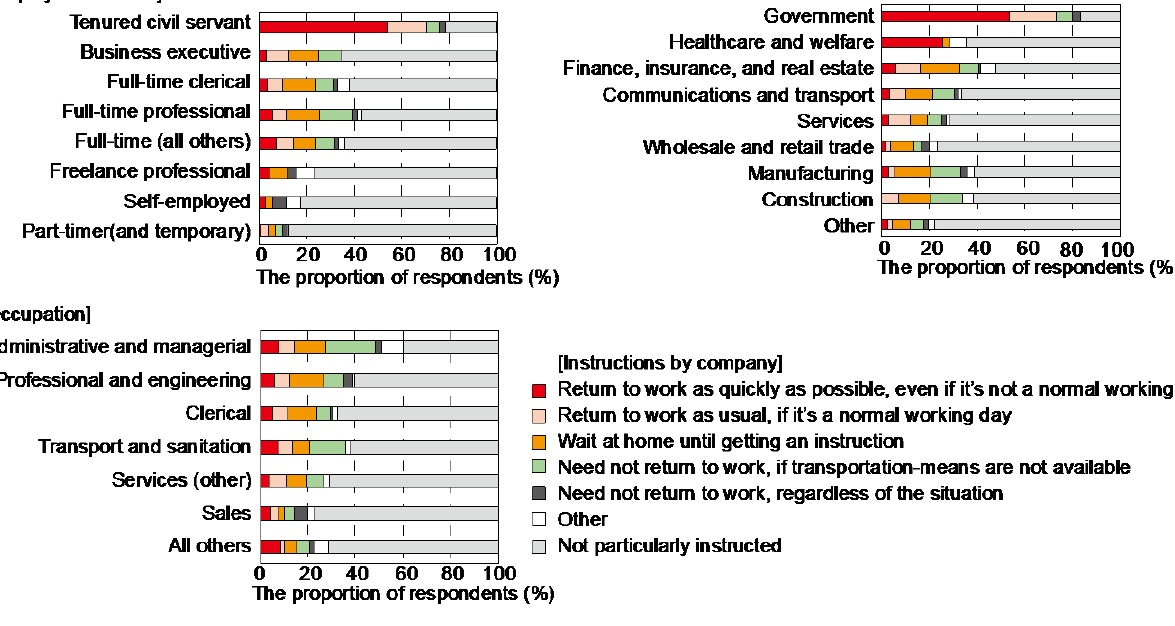
Figure 2. Disaster-preparedness instructions by employment type, job, and skill categories.